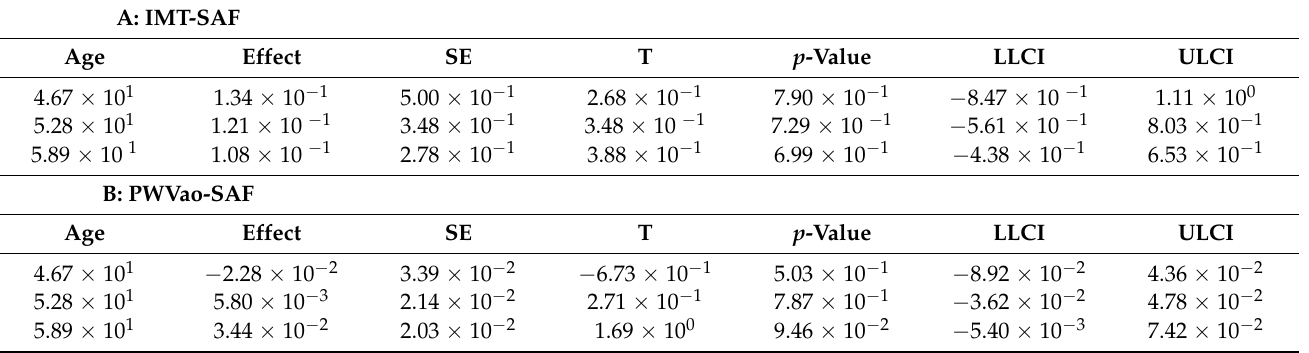
Table 2. Conditional effects of IMT ( A ) or PWVao ( B ) on skin SAF at the values of the moderators in the cohort n = 77. Three representative age values were chosen. SE stands for standard error. T-value is abbreviated as T.